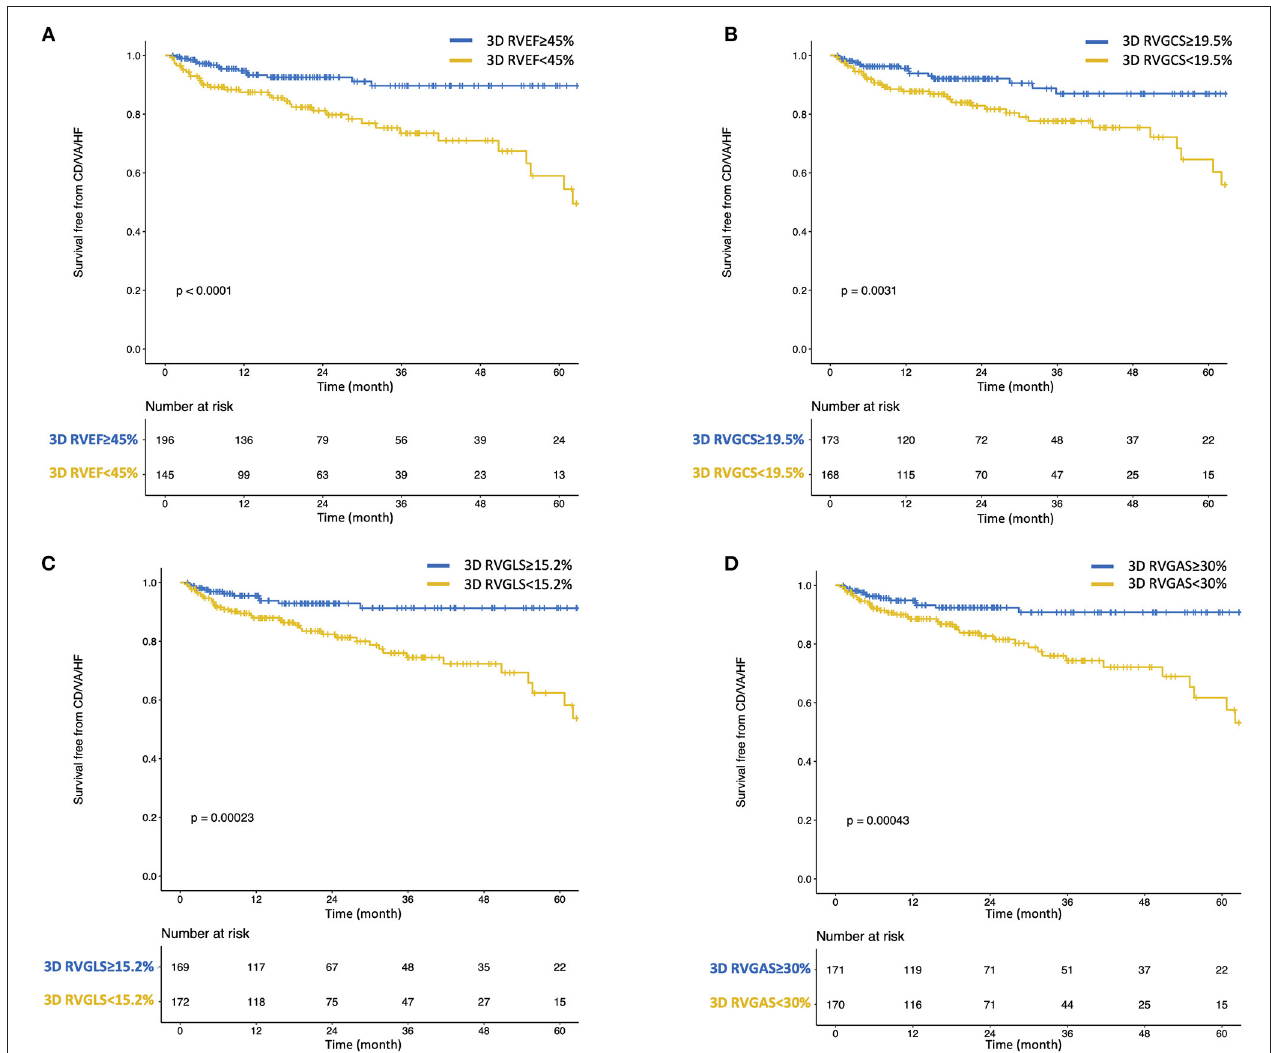
FIGURE 3 | Kaplan-Meier survival curves for cardiac death, ventricular tachyarrhythmia, or heart failure hospitalization stratified by predefined cut-off value of 3D RVEF (A) and median values of 3D RVGCS (B) , 3D RVGLS (C) , and 3D RVGAS (D) . CD, cardiac death; HF, heart failure; VA, ventricular tachyarrhythmia.